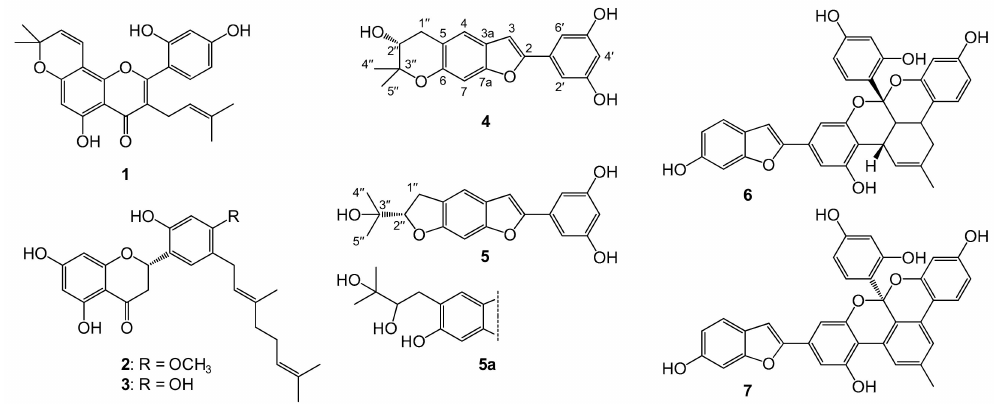
Figure 2. Phenolic compounds isolated from the root bark of Morus nigra . These are morusin ( 1 ), kuwanon U ( 2 ), kuwanon E ( 3 ), moracin P ( 4 ), moracin O ( 5 ), albanol A ( 6 ), and albanol B ( 7 ).